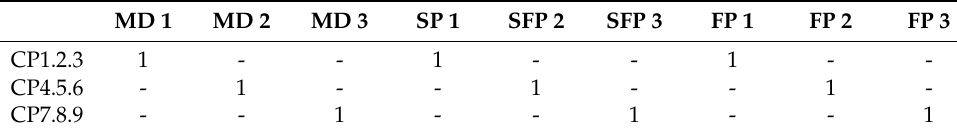
Table 2. Quantitative relationships between materials.